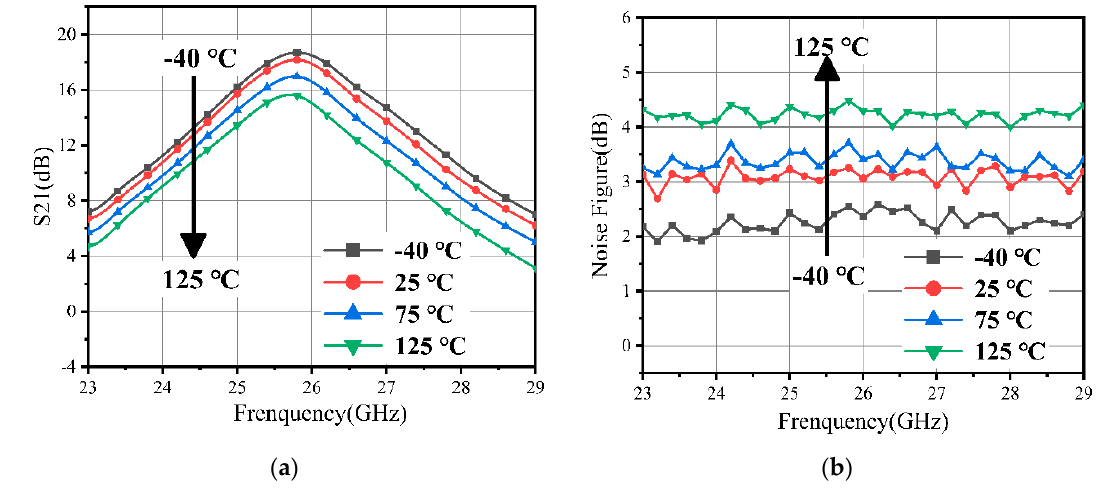
Figure 10. ( a ) Measured S21 at different temperatures; ( b ) measured NF at different temperatures.